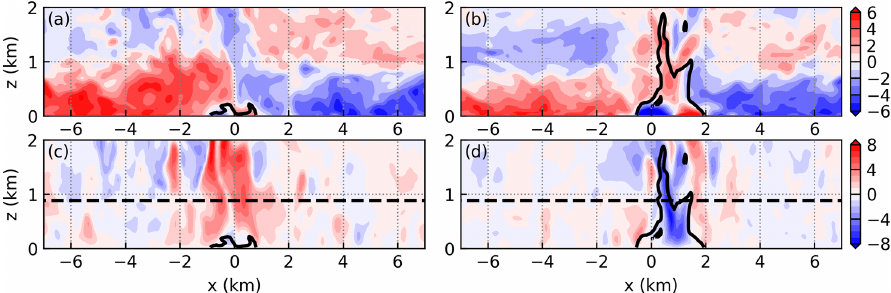
Figure 12. Vertical cross section of (a) cross-coast wind and (c) vertical velocity at y = − 0 . 95km. Panels (b) and (d) are, respectively, the same as (a) and (c) except at y = − 4 . 95km. The black contour indicates the edge of the cold pool. The dashed line indicates the LFC. The results are at t = 8h of simulation THF700.